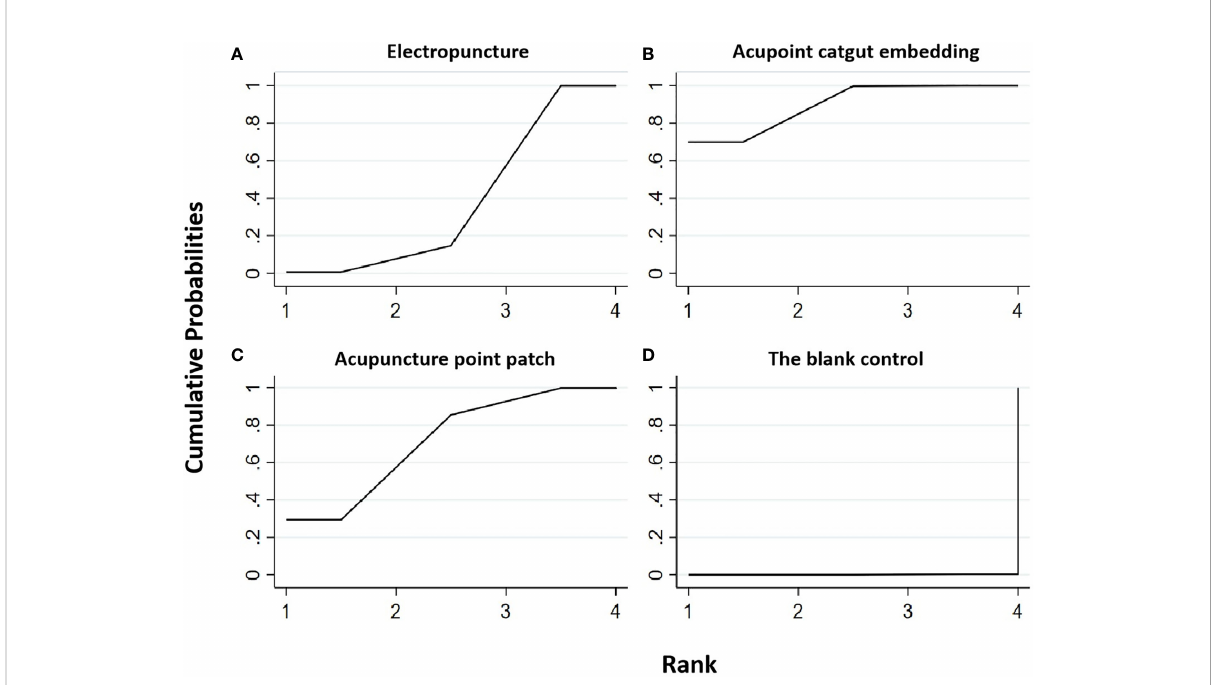
FIGURE 6 Ef fi cacy ranking and cumulative probability graph of body mass index (BMI) treated by different types of intervention. Comparison of ef fi cacy ranking and cumulative probability of BMI between each kind of intervention. (A) Electropuncture, (B) acupoint catgut embedding, (C) acupuncture point patch, and (D) blank